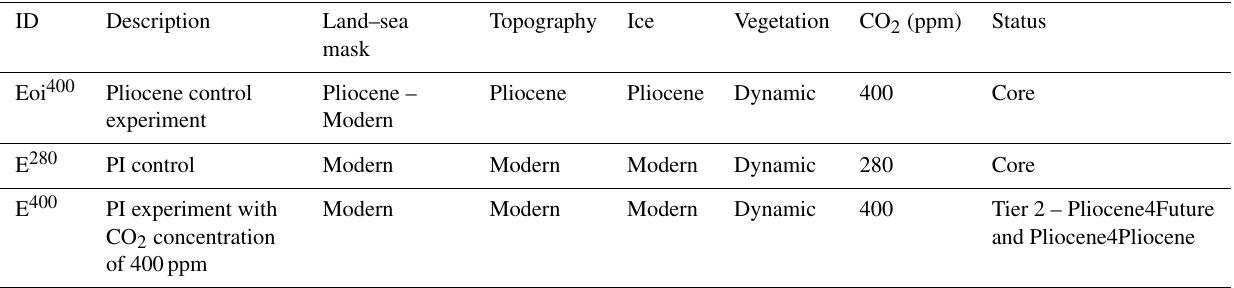
Table 3. Details of the PlioMIP2 experiments included in the FCO 2 analysis (adapted from Haywood et al., 2016). Note that dynamic vegetation was optional in the experimental design; only COSMOS ran with dynamic vegetation, and all other models ran with the prescribed vegetation of Salzmann et al. (2008). As COSMOS ran with dynamic vegetation, some vegetation feedback in this model will be included in the E 400 -E 280